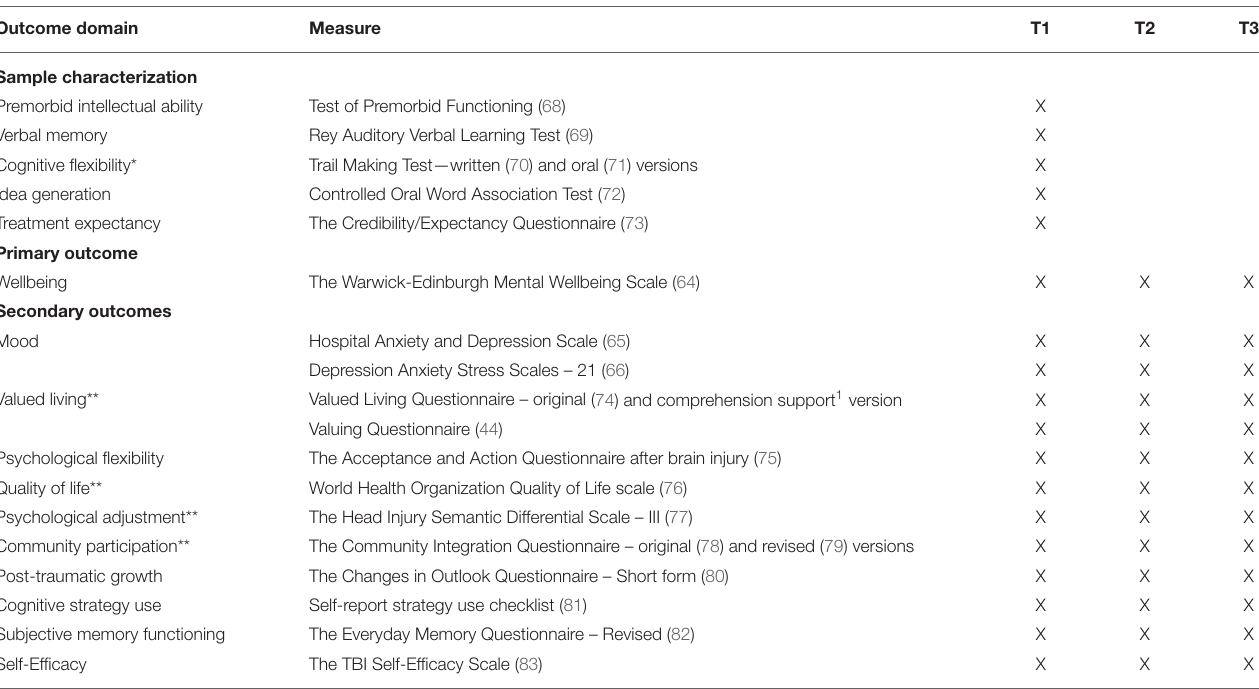
TABLE 3 | Timing of outcome